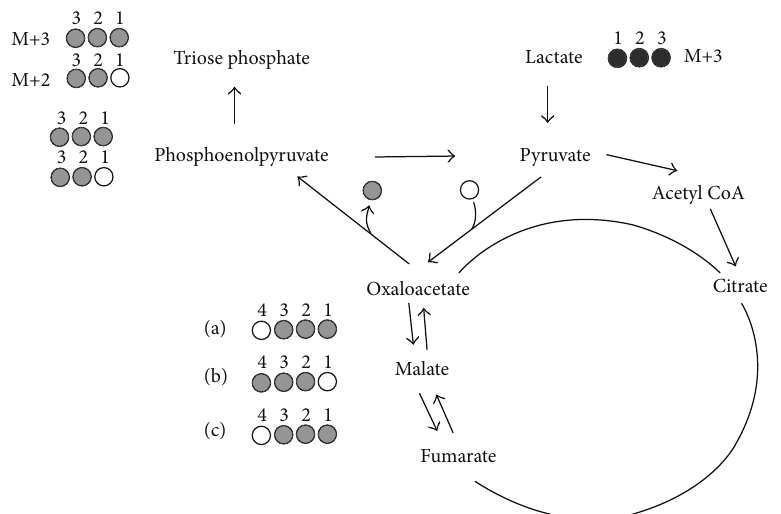
Figure 3: Generation of [2,3- 13 C 2 ]triose-P (M+2) and [1,2,3- 13 C 3 ]triose-P (M+3) isotopomers from [1,2,3- 13 C 3 ]lactate via gluconeogenesis. The intermediate isotopomers of oxaloacetate are also shown. In the absence of pyruvate cycling and with extensive exchange of oxaloacetate with malate and fumarate, equal amounts of oxaloacetate isotopomers (a) and (b) are formed that result in the generation of equal amounts of M+2 and M+3 triose-P isotopomers. With pyruvate cycling, equal proportions of isotopomers (a) and (b) are converted to isotopomer (c). Since isotopomer (b) is the sole precursor of M+3 triose-P while isotopomers (a) and (c) both contribute to M+2 triose-P, this results in an excess of M+2 over M+3